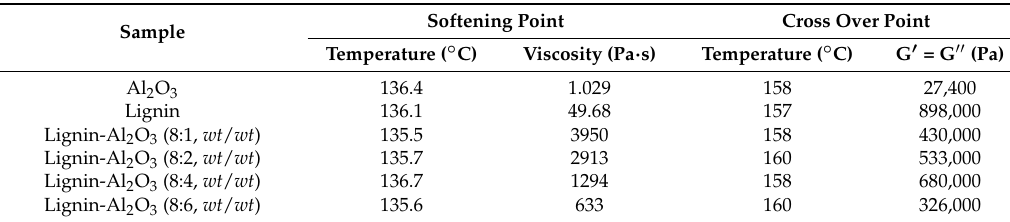
Table 5. Characteristic points for the curing